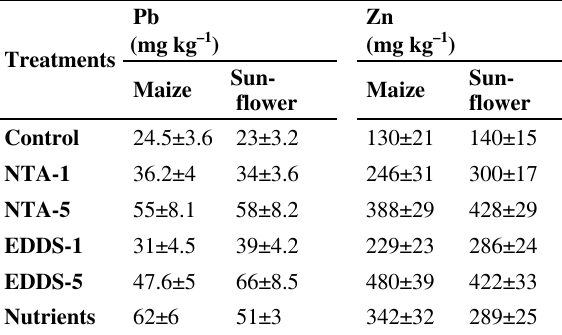
Table 3 . Influence of NTA, EDDS and nutrients on lead and zinc content in the leaves of maize and sunflower. The results are presented as the mean and standard errors